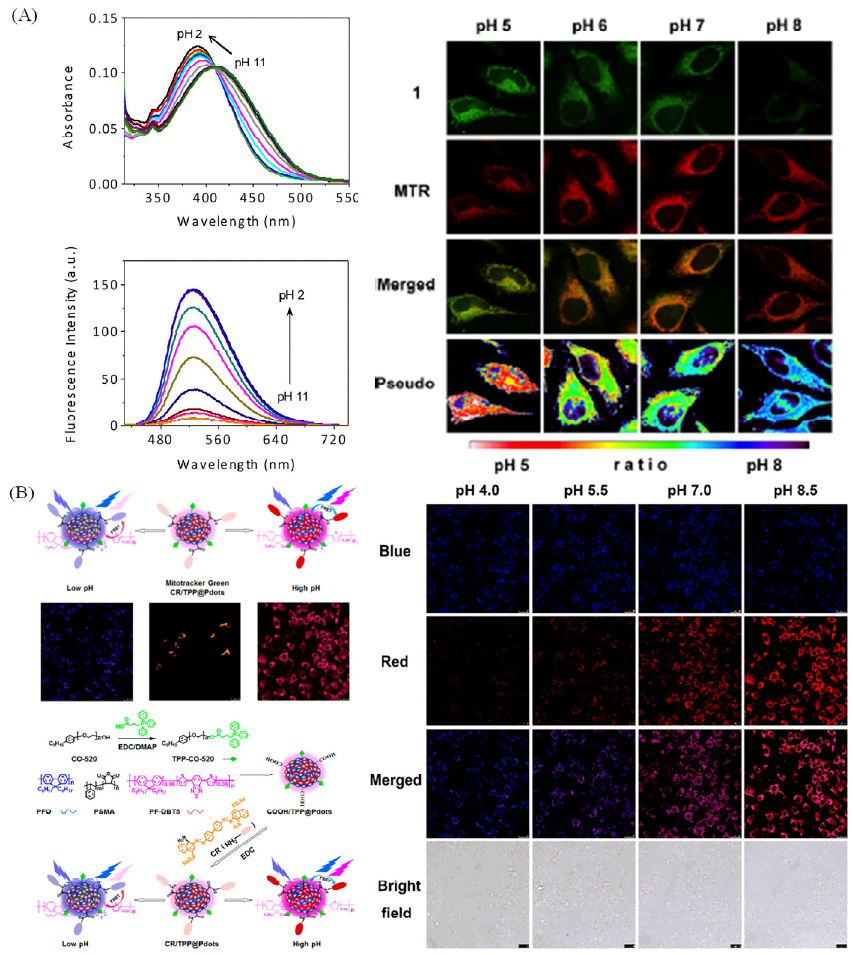
Figure 14. ( A ) Fluorescence spectra of in diverse pH solutions, and its fluorescence pictures in fixed cells. Reproduced from 80 with the American Chemical Society, copyright 2014. ( B ) Synthesis of CR/TPP@Pdots and its applications in HeLa cells with diverse pH values. Reproduced from [79] with permission of the American Chemical Society, copyright 2017.